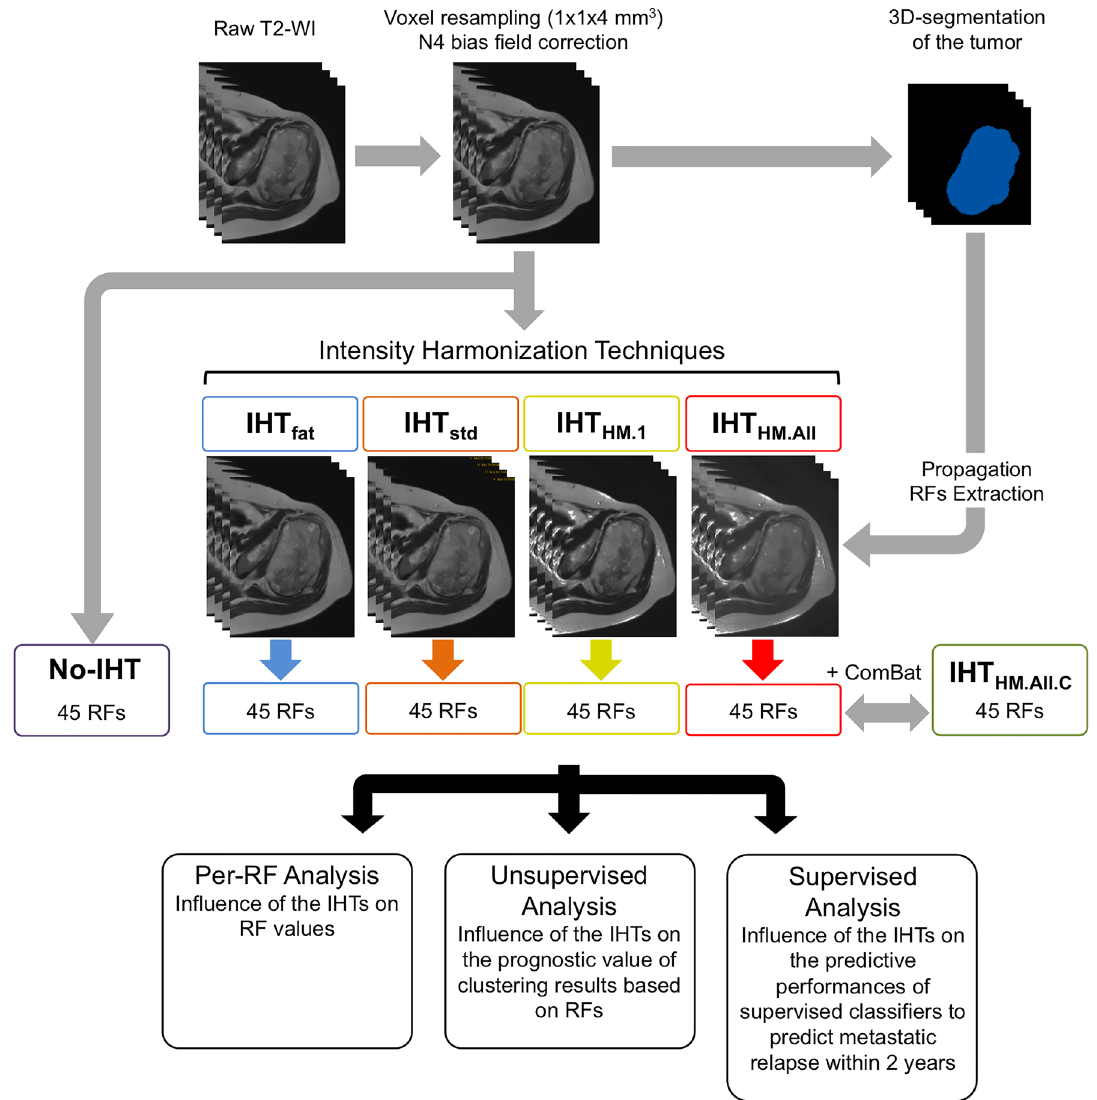
Figure 1. Study pipeline. HM histogram matching, IHT intensity harmonization technique, No-IHT no use of IHT before extracting radiomics features, RF radiomics features, WI weighted